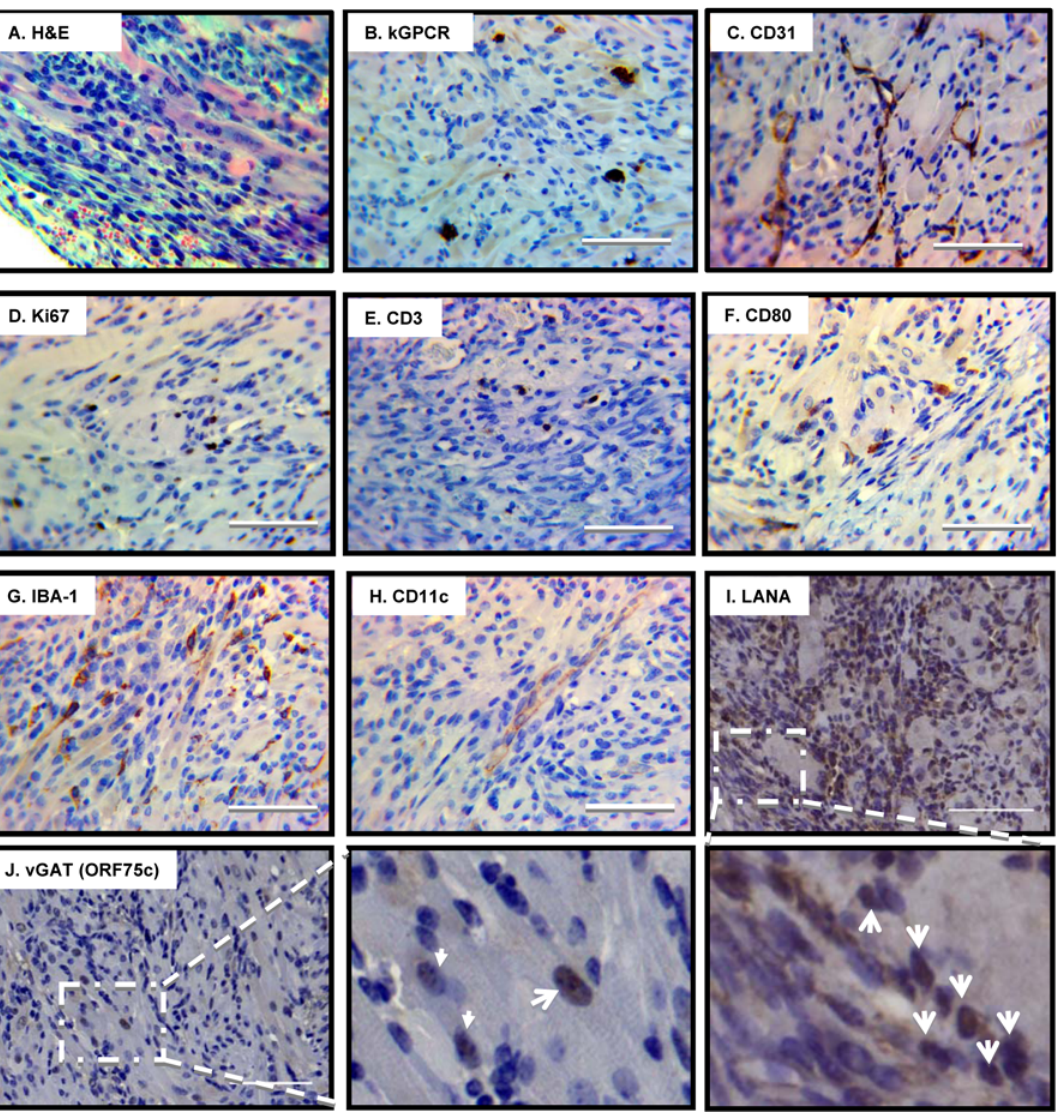
Fig 6. Pathological analysis of angiogenic tumors derived from γ HV68.kGPCR-infected mice. Subcutaneous tumors developed in γ HV68.kGPCR- infected BALB/c mice were analyzed by hematoxylin & eosin (H&E) staining (A) and immunohistochemistry staining with antibodies against the HA epitope (kGPCR, B), endothelial marker CD31 (C), proliferation marker Ki67 (D), T cell marker CD3 (E), CD80 (F), macrophage marker IBA-1 (G) and dendritic cell marker CD11c (H). Tumors were also analyzed by immunohistochemistry staining with antibodies against γ HV68 LANA (ORF72, latent antigen) (I) and vGAT (ORF75c, lytic antigen) (J). Boxed regions were amplified right below (I) or next (J) to the original images. Scale bars denote 25 μ m.